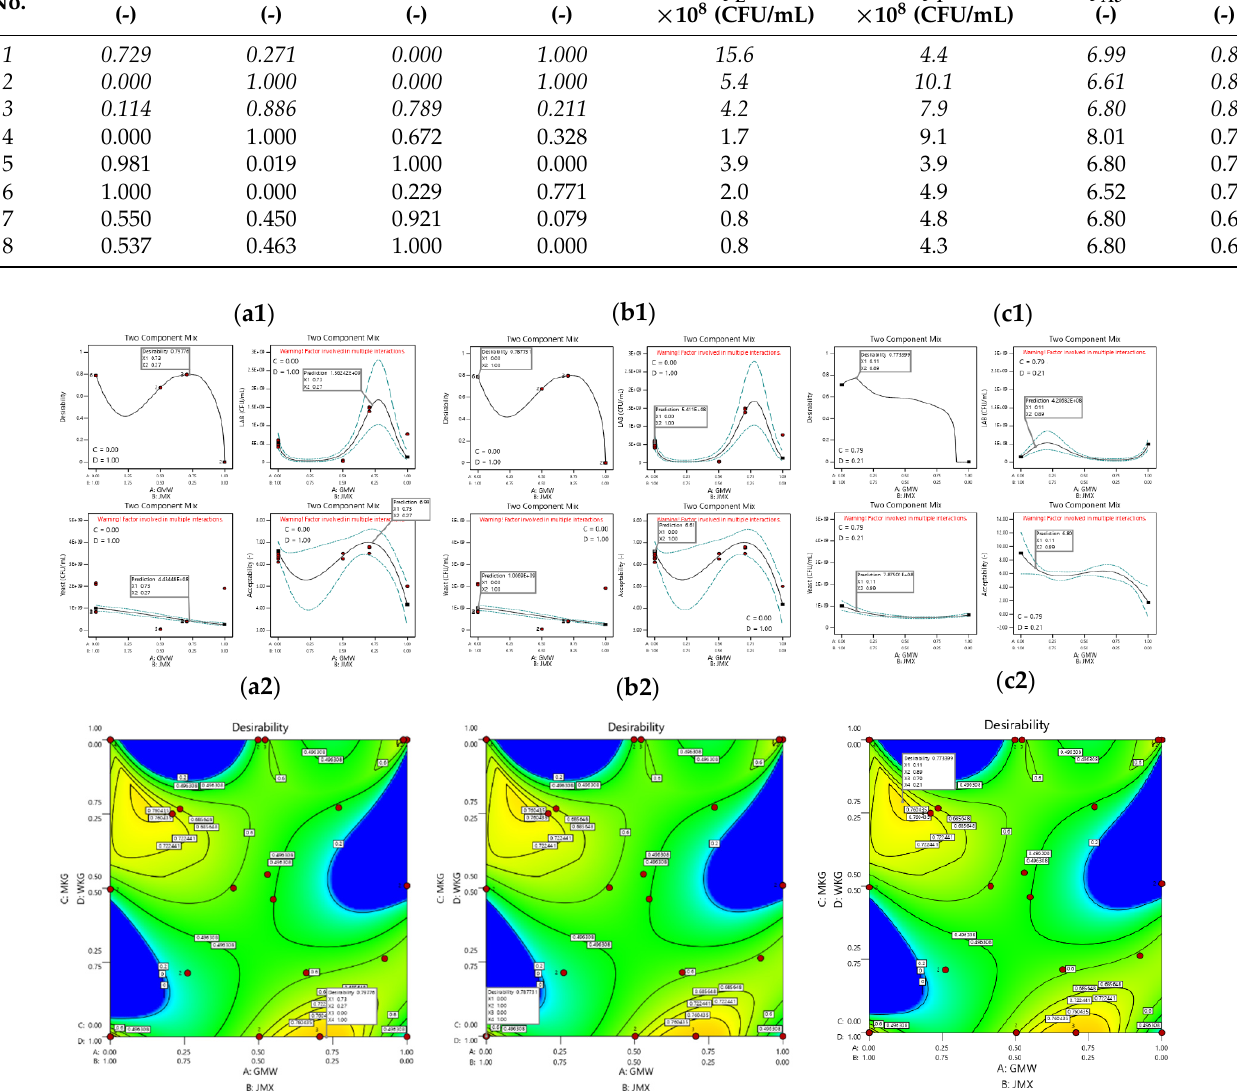
Figure 4. The three optimal values suggested with the highest values of desirability D-function were used in the validation experiments of the models and for the comparison of the chemical-physical properties. Upper side ( a1 – c1 ) multiple responses under optimal conditions. Lower side ( a2 – c2 ) 2D plots of desirability function. ( a1,a2 ) OPT1 (x 1 (A) = 0.73, x 2 (B) = 0.27; x 3 (C) = 0.00, x 4 (D) = 1.00); ( b1,b2 ) OPT2 (x 1 (A) = 0.00, x 2 (B) = 1.00; x 3 (C) = 0.00, x 4 (D) = 1.00); ( c1,c2 ) OPT3 (x 1 (A) = 0.11, x 2 (B) = 0.89; x 3 (C) = 0.79, x 4 (D) = 0.21). Table 3. Conditions of factors A-D, in mixtures 1 and 2, for which the suggested optimal values are obtained, by simultaneously maximizing the individual responses, with average and equal levels of relative importance between them.